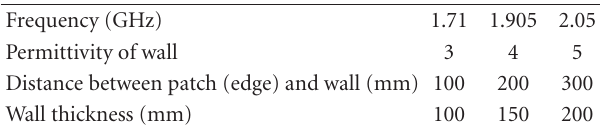
Figure 8: Distribution of ISPG for the perpendicular patch-wall case.